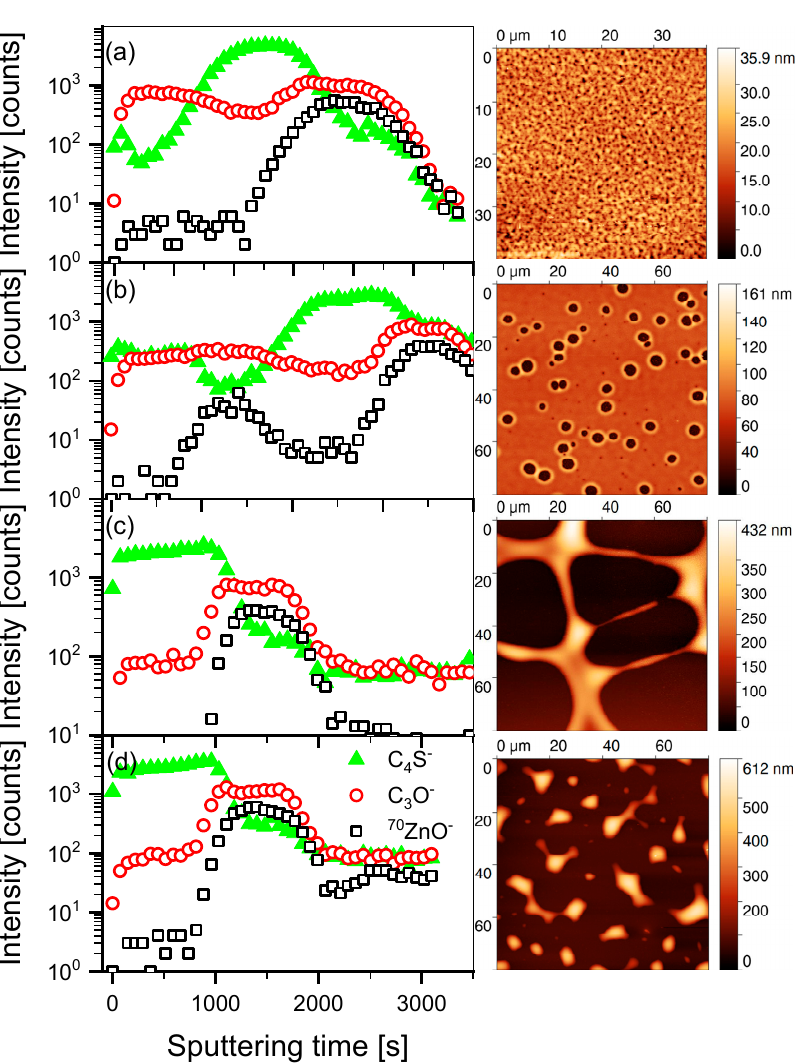
Figure 6. SIMS profiles and AFM topographic images of PC 60 BM/P3HT bilayers prepared on ZnO and exposed to chloroform vapor for time: ( a ) 0, ( b ) 5, ( c ) 10, and ( d ) 30 min.